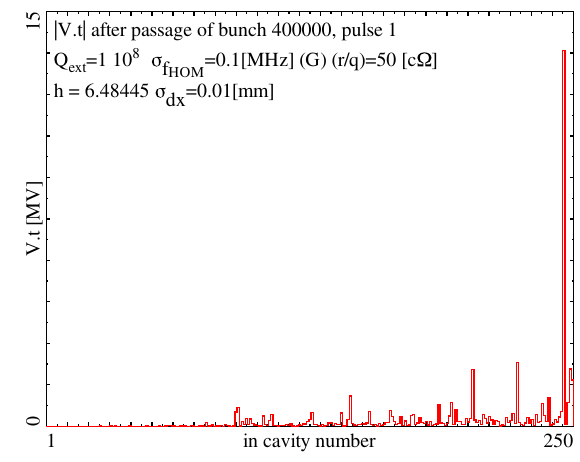
FIG. 53. (Color) x [mm] of the last bunch, conditions as in Fig. 48.